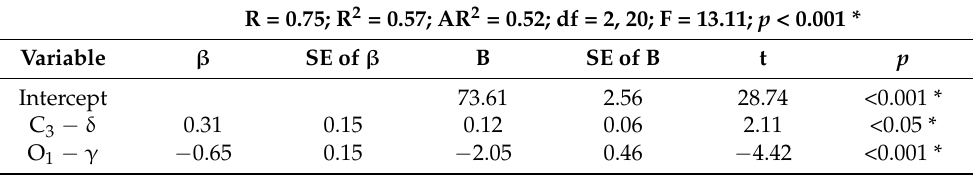
Table 4. Regression analysis for normalised low frequency heart rate variability and electroen- cephalography variables in train drivers.